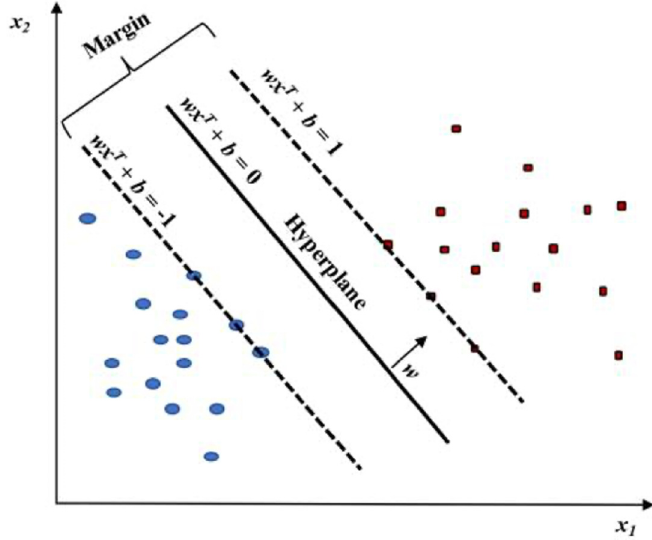
Figure 2. Linear SVM model classifying red vs. blue data points.